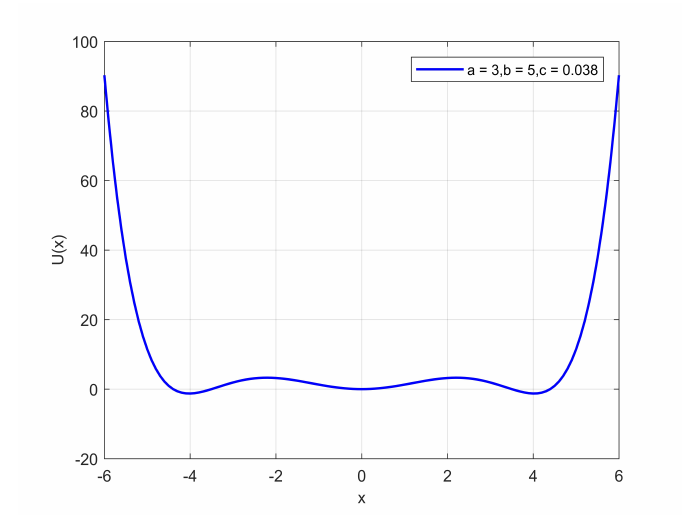
Figure 2. The curve of at a = 3, b = 5, c =